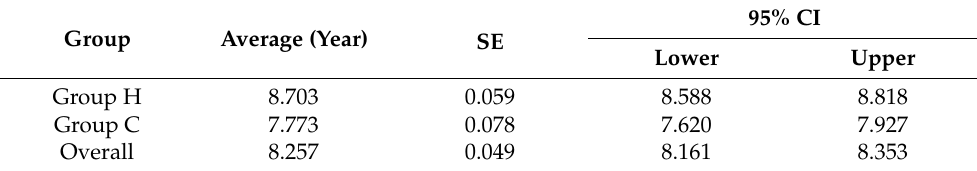
Table 2. Comparison of mean SSNHL free Table 1. Characteristics of the study participants and incidence of comorbidities.